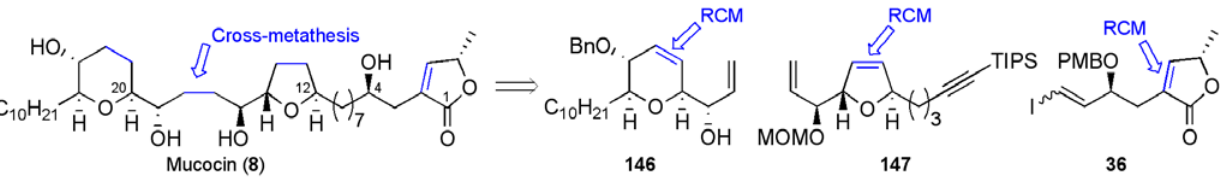
Figure 20. Crimmins’ strategy for the synthesis of mucocin ( 8 )